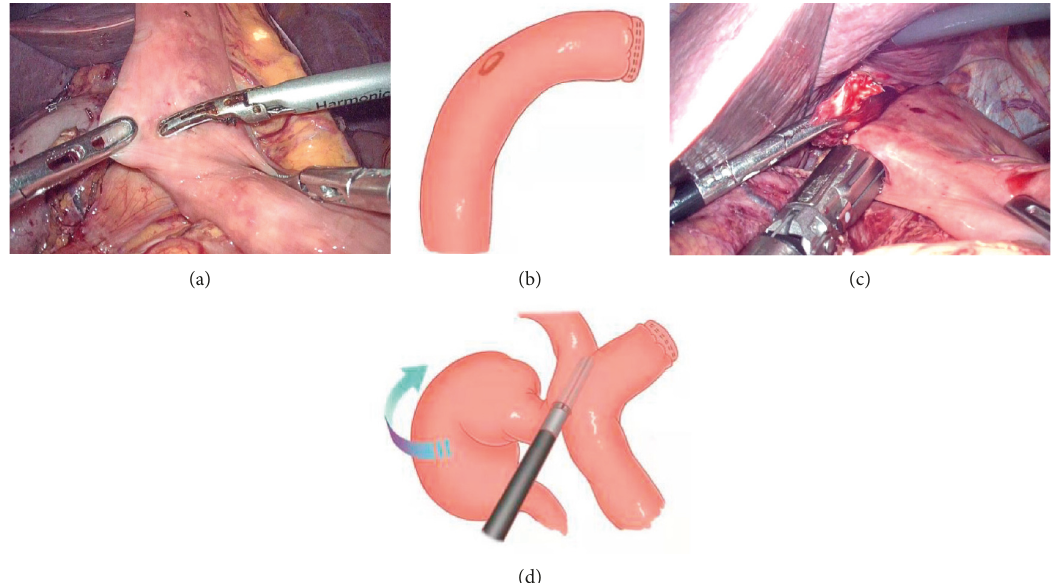
Figure 3: (a, b) The intestinal wall was drilled 8cm away from the stump. (c, d) Jejunum was lifted and a linear stapler was used to perform side-to-side anastomosis between the posterior wall of the esophagus and the opposite limbus of the